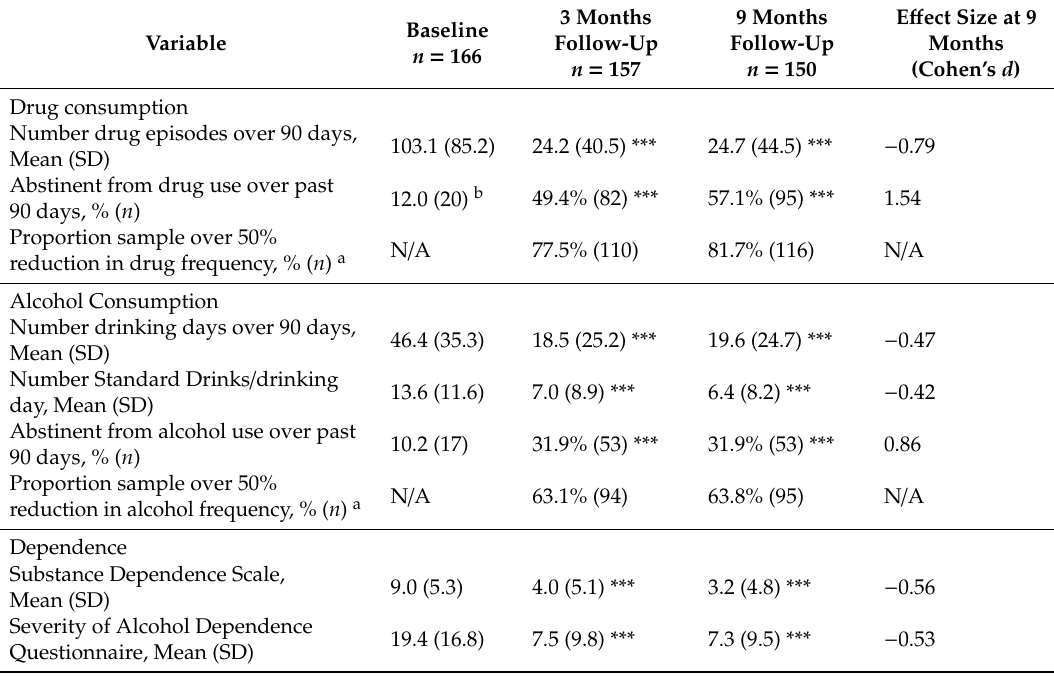
Table 2. Drug and alcohol outcomes and clinically significant